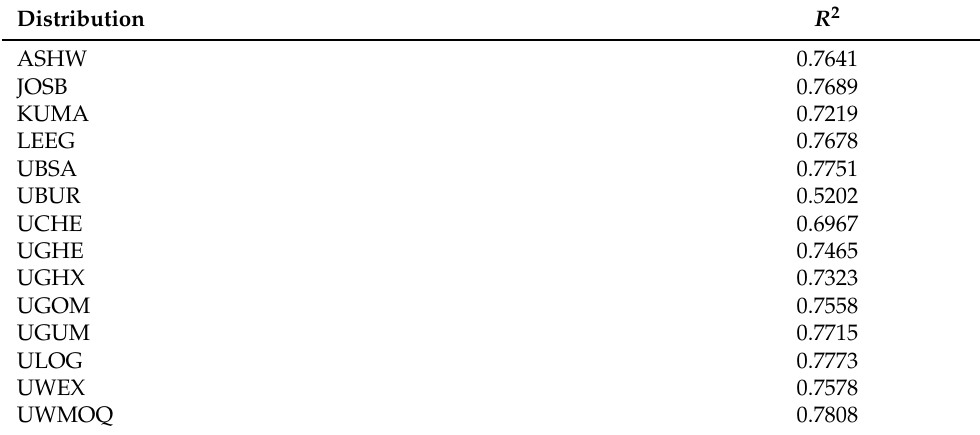
Table 15. Coefficient of determination ( R 2 ) for the indicated distribution with data related to fat percentage at the legs.